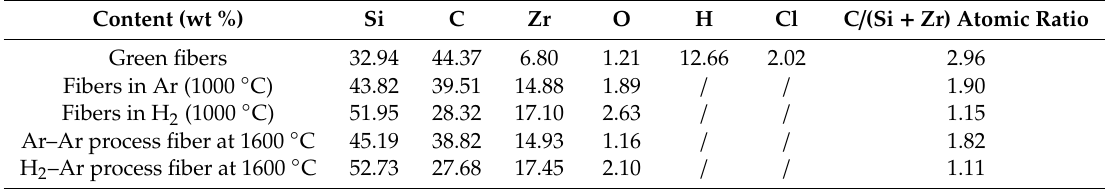
Table 1. Content and C / (Si + Zr) Atomic ratio of di ff erent